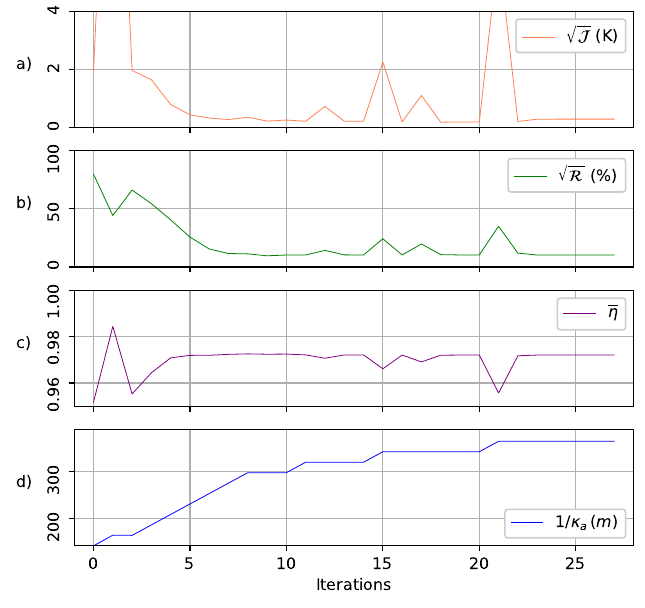
√ √ J (K), ( b ) correlation function R ,